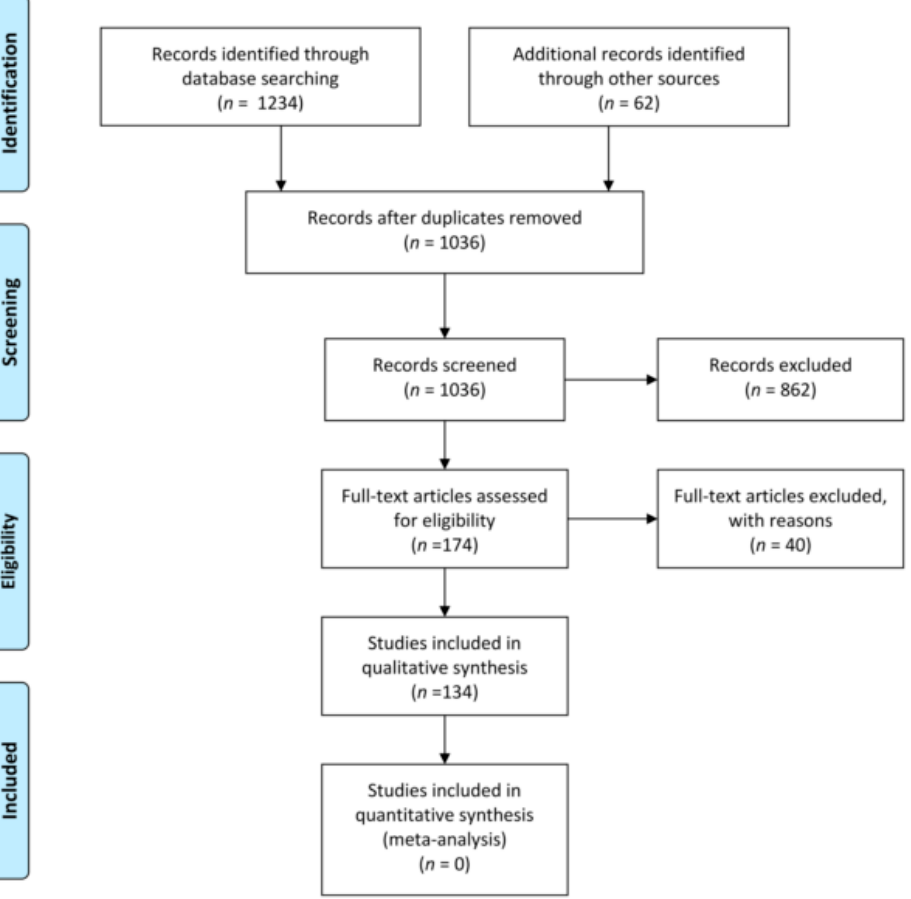
Figure 1. Flow diagram depicting the search and selection of the study process according to the Preferred Reporting Items for Systematic Reviews and Meta-Analyses (PRISMA) statement.